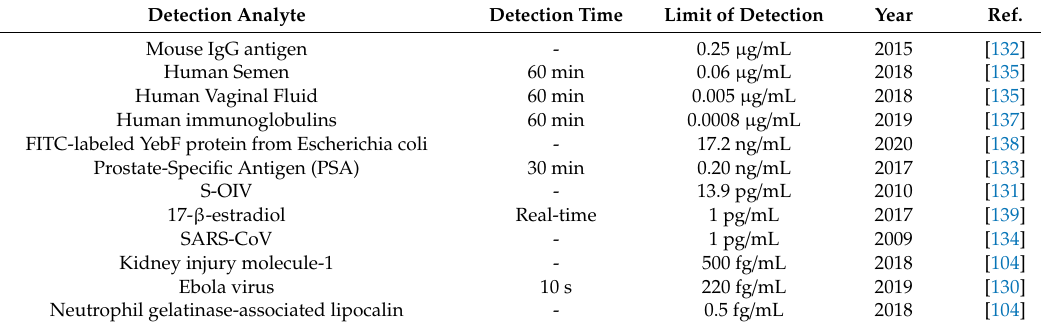
Table 5. Overview of metal enhanced fluorescence-based biosensors for the detection of various analytes, with information on detection limit, detection time, and publication information such as year and reference, for further